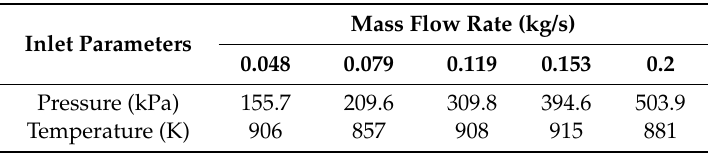
Table 4. Turbine dimensions. Table 3. Test data used for calculations of VGT boundary conditions.